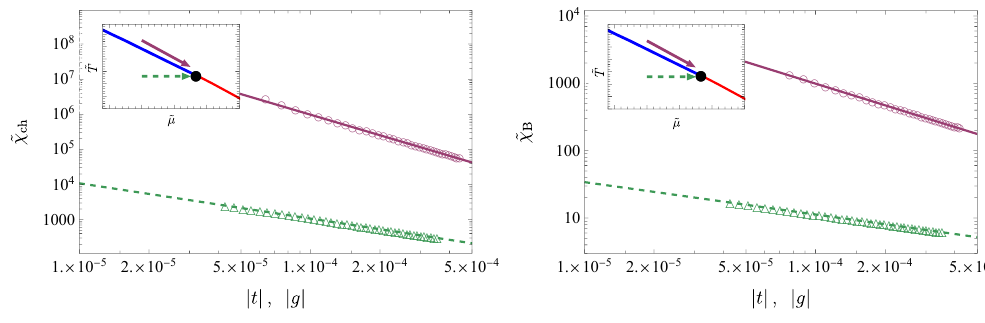
Figure 11 . The critical behaviors of the chiral susceptibility (left panel) and the baryon number susceptibility (right panel) in log scale. Each plot shows the critical behaviors for the two different paths denoted by the arrows in the